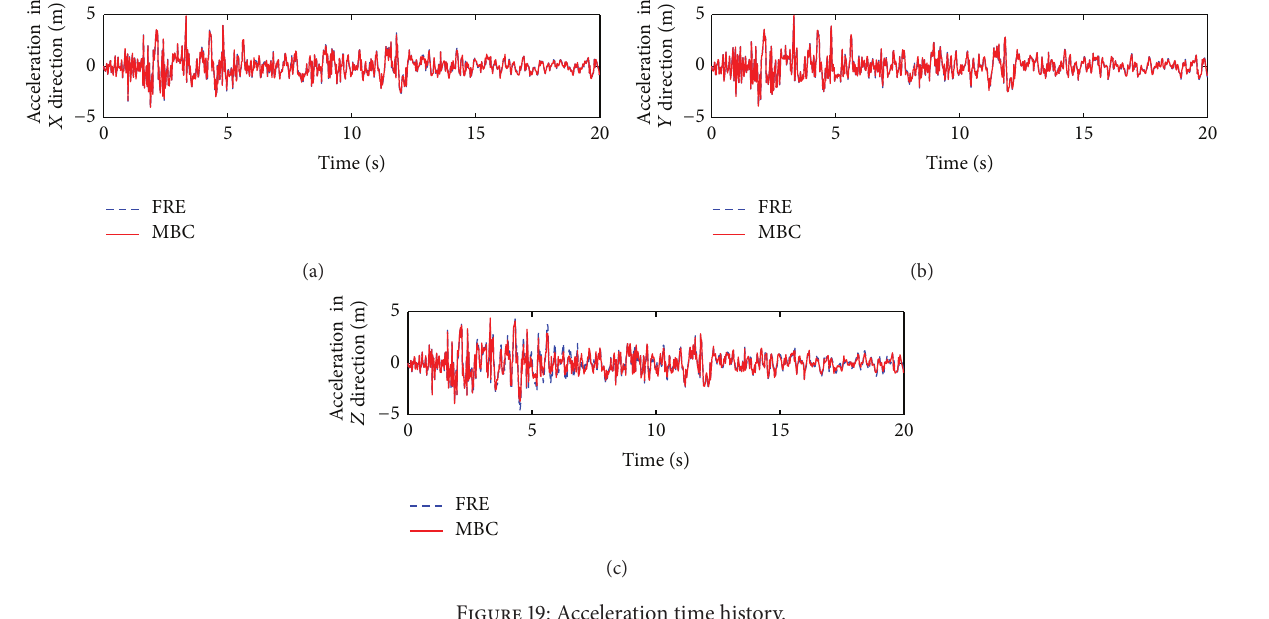
Figure 19: Acceleration time history.